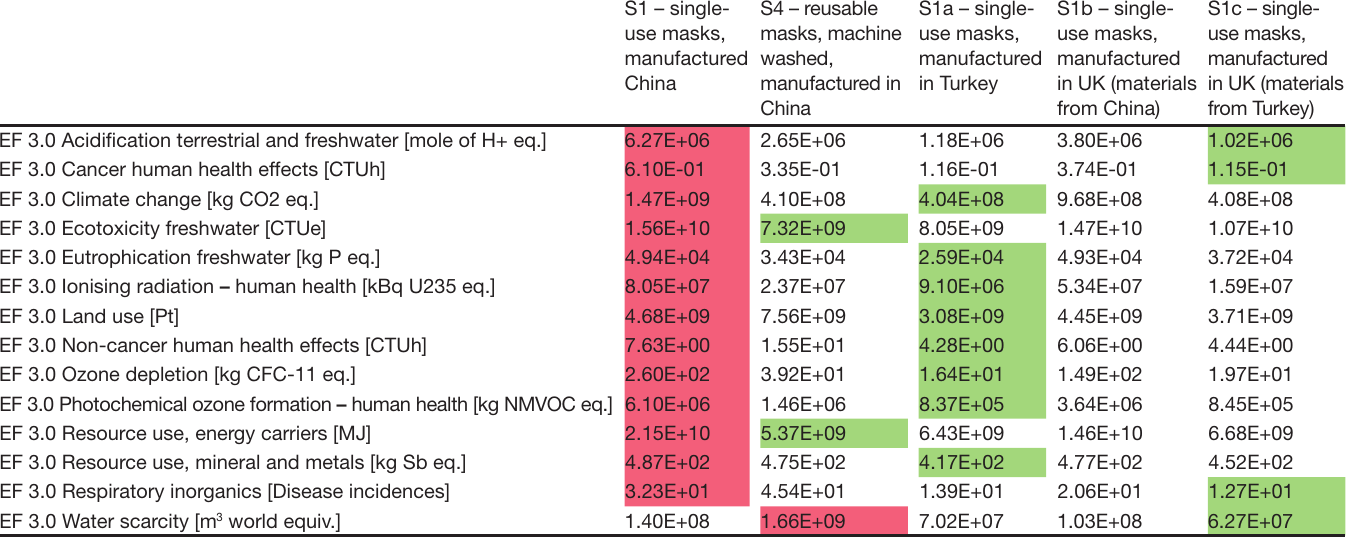
Table A13. Overall environmental impact results for the new single-use face masks supply scenarios compared to Scenario 4 (use of four reusable masks in rotation and machine-washed).